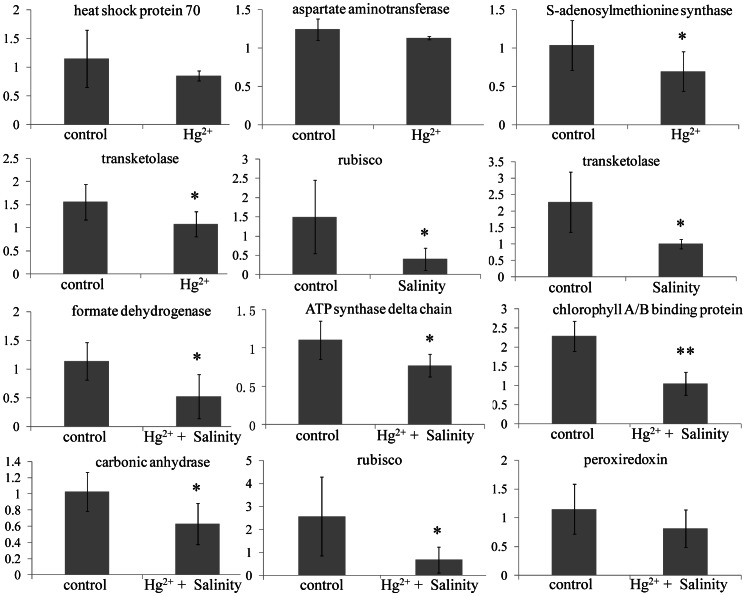
Expression levels of eleven genes in leaf tissues of Suaeda salsa from control, Hg2+ (20 µg L−1), salinity (NaCl, 500 mM) and Hg2++salinity-treated groups after exposure for 30 days.Data (n = 6) were expressed as mean ± standard deviation. Significant difference between control and exposed groups was tested by one-way analysis of variance with Tukey’s test and indicated by *(P<0.05) and **(P<0.01).